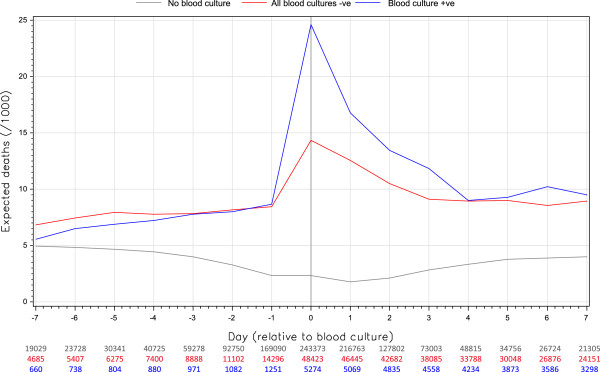
Daily expected risk of death by blood culture status. The daily hazard of death was calculated for each person using a validated predictive model that captured daily values of important, patient-level covariates
[22]. Within each group (no blood culture [red], negative blood culture [grey], positive blood culture [blue]), these were summed and standardized to 1000 population (vertical axis). The horizontal axis displays the hospital day relative to the first blood culture; for patients with no blood culture, the hospitalization midpoint was used as the reference. The dip in the ‘no blood culture’ group is due to increased prevalence at zero time of short stay admissions (which have the lowest expected risk of death).